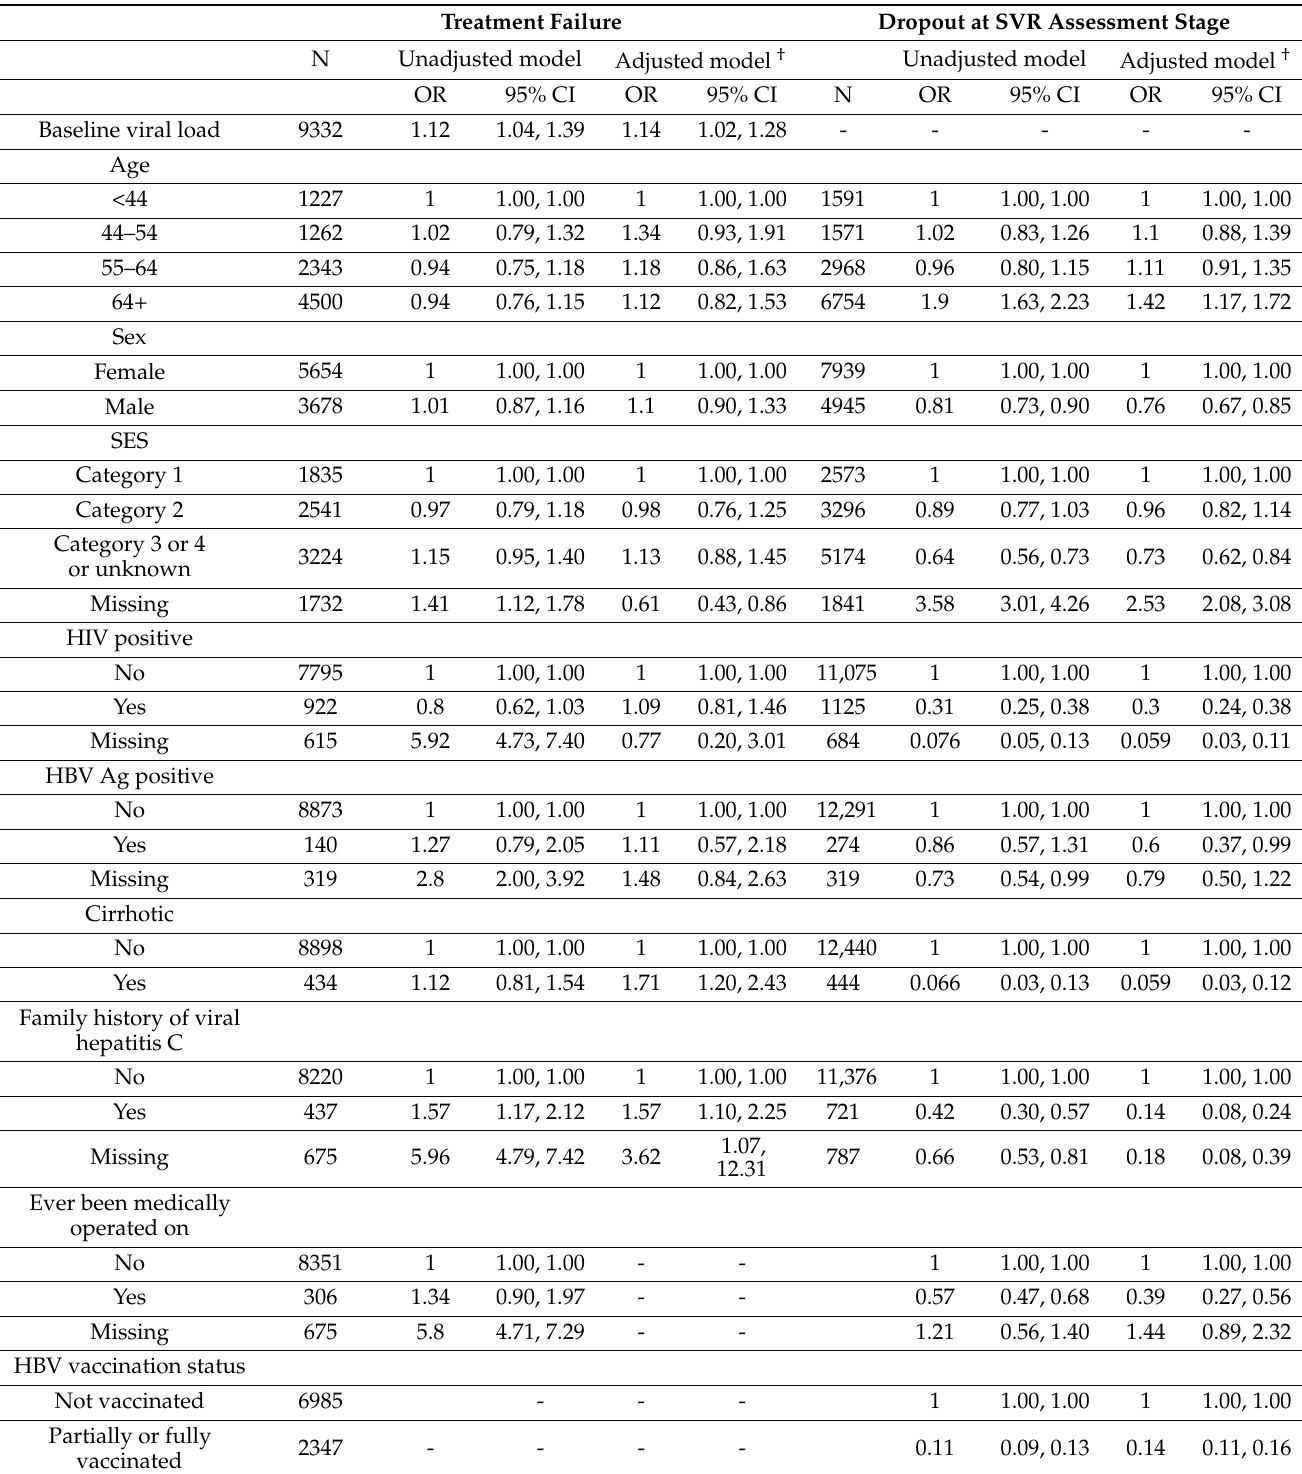
Table 6. Adjusted and unadjusted relationships between treatment failure, dropout at SVR assessment stage, and socio-economic, demographic, clinical, behavioral, and hospital characteristics